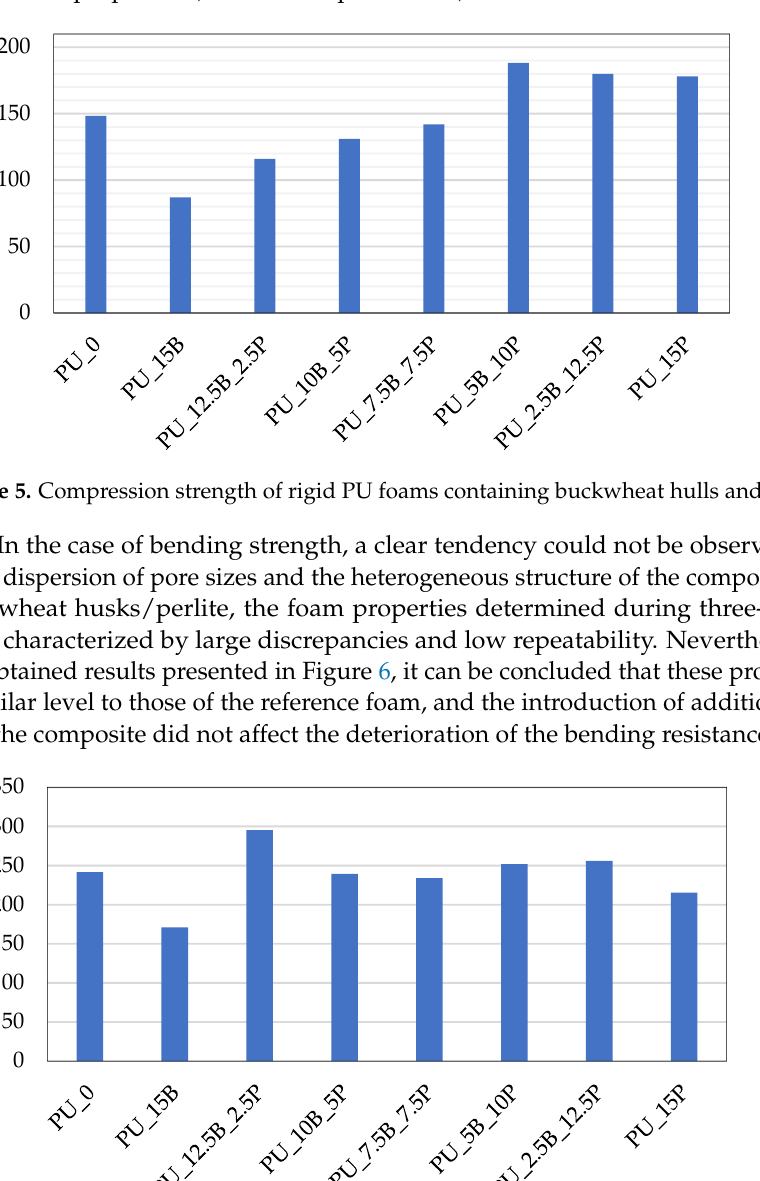
Figure 7. Toughness of rigid PU foams containing buckwheat hulls and perlite. 5.3. Water-Related Properties The water-related properties of composite foams were assessed using water uptake and contact angle methods. The water absorption ability of materials characterized by a porous structure depends mostly on their cell structure (whether the cells are open or closed) and hydrophilic-hydrophobic nature. As presented in Figure 8, the addition of buckwheat hulls/perlite modifiers noticea- bly changed the water absorption capacity and contact angle values of analyzed polyure- thane foams. Compared with the unmodified foam PU_0, the water uptake increased with increases in the buckwheat husks content (the highest value was achieved by PU_15B and was 76.3%) and decreased with increases in the perlite content, achieving a water uptake value (22.5%) for the PU_15P foam that was lower than that for pure, unmodified foam,